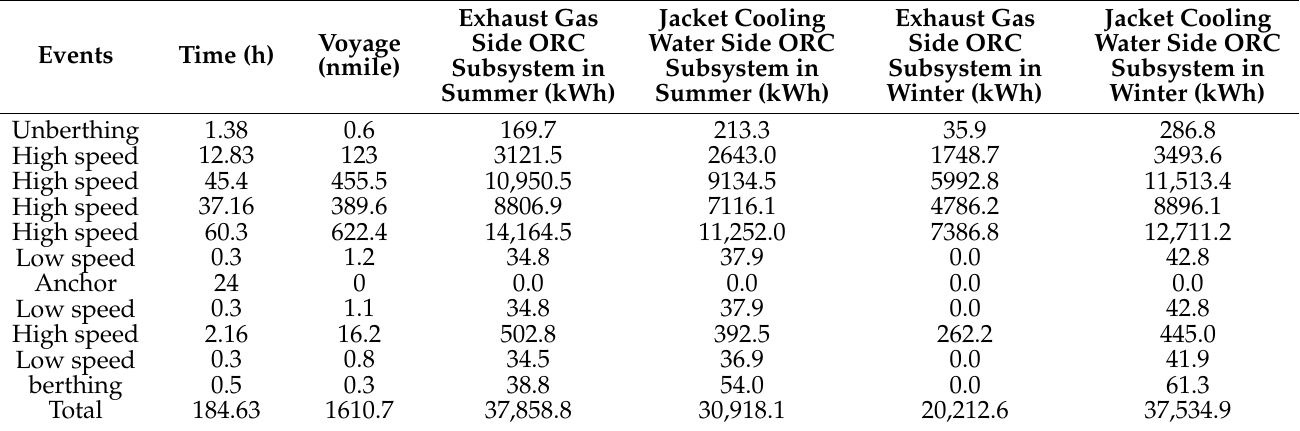
Table 10. Total work or amount of energy saving produced by ORC system when adopting high-sulfur fuel oil.